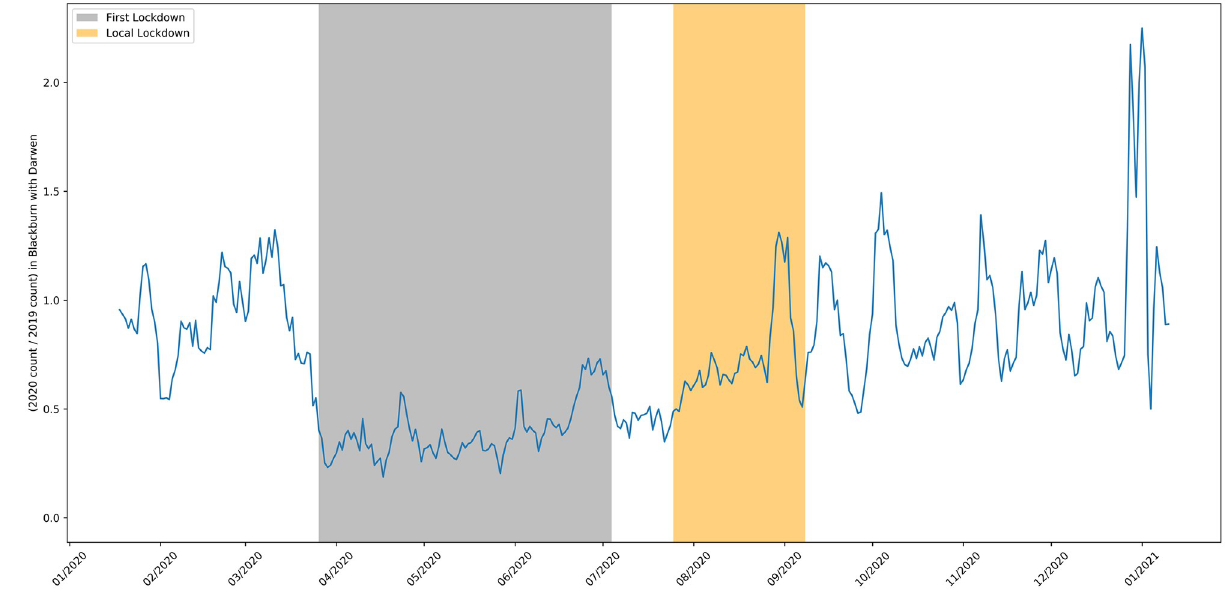
Fig 16. The 2020 to 2019 ratio of job adverts in area of Blackburn with Darwen.